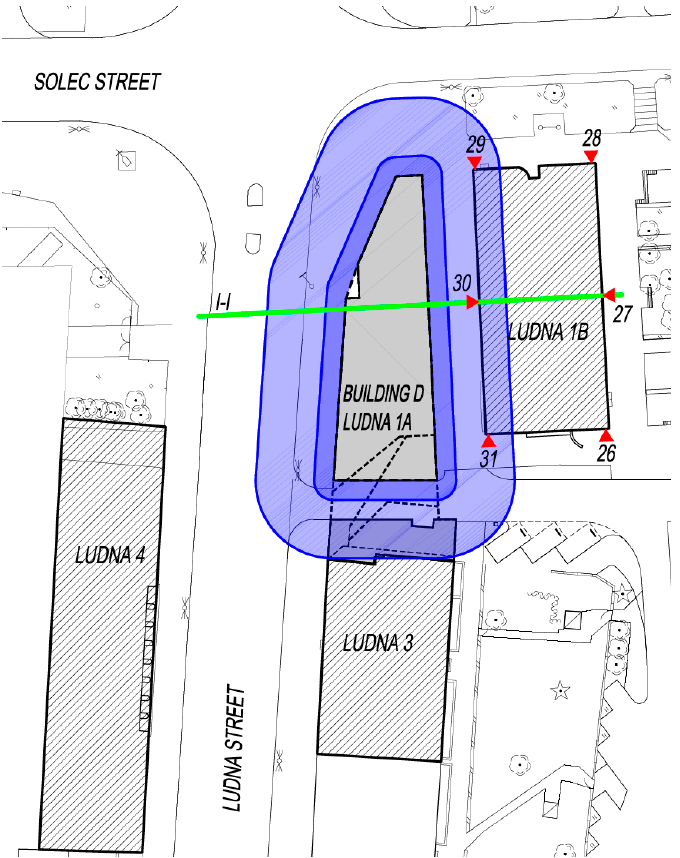
Figure 6. Scheme of the building design indicating the ranges of the zones of impact of the excavation on the adjacent developments.